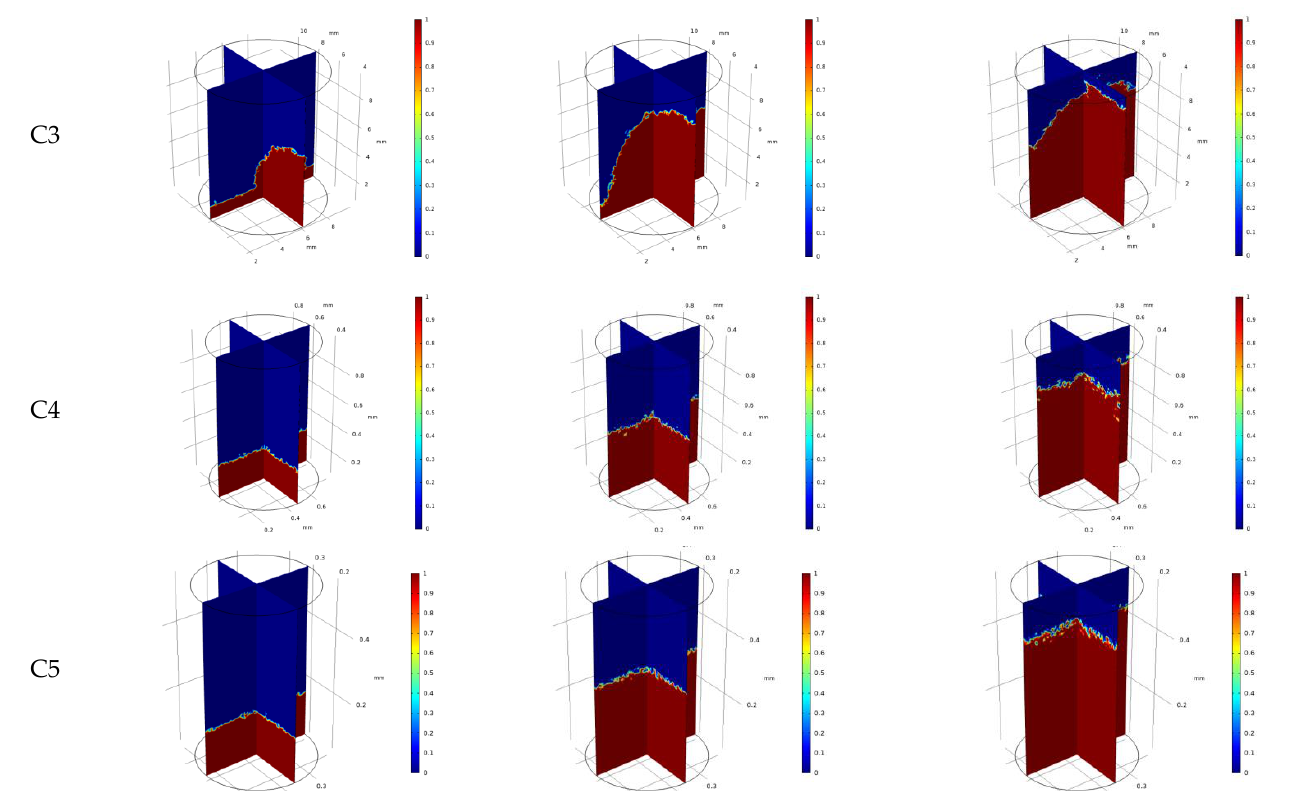
Figure 17. Variation of phase distribution with injected volume (blue for water phase, red for natural gas phase, p c = 10 MPa, p g = 325 kP, p w = 200 kPa).